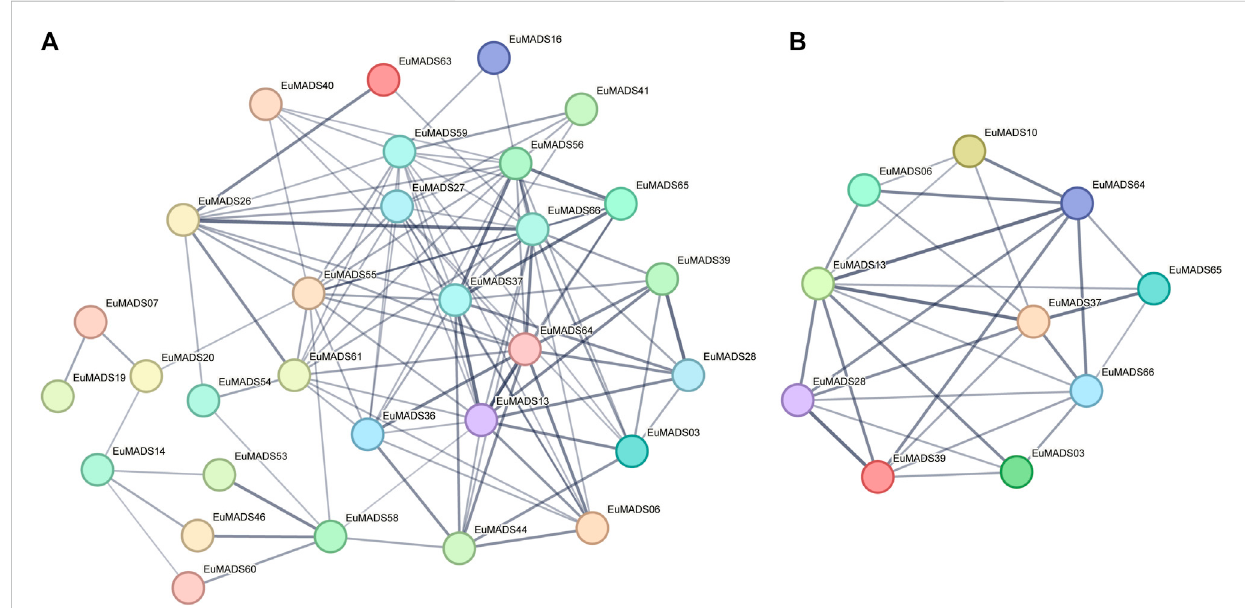
FIGURE 8 Putative interactions between EuMADS proteins. (A) Prediction of the protein interaction network among 66 EuMADS. (B) Prediction of the protein interaction network among 14 EuMADS involved in the fl oral organ ‘ ABCDE model ’ .